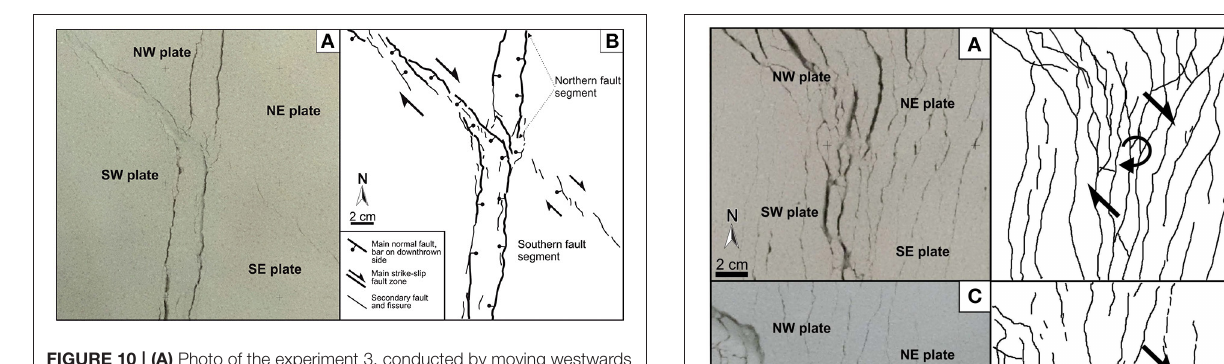
FIGURE 10 | (A) Photo of the experiment 3, conducted by moving westwards at differential velocities and amount the NW, SW, and SE plates, and keeping the NE plate fixed. (B) Sketch of the photo with indication of the main and secondary faults and extensional fractures. Note the strong similarity with the real field data of the same area, as shown in Figure 3 . The HFF gradually bends toward the south near the junction with the GF. North of it, the northern fault segment bends toward the SE. Southeast of the junction, a series of en-échelon, left-stepping fractures developed, as observed in the field.